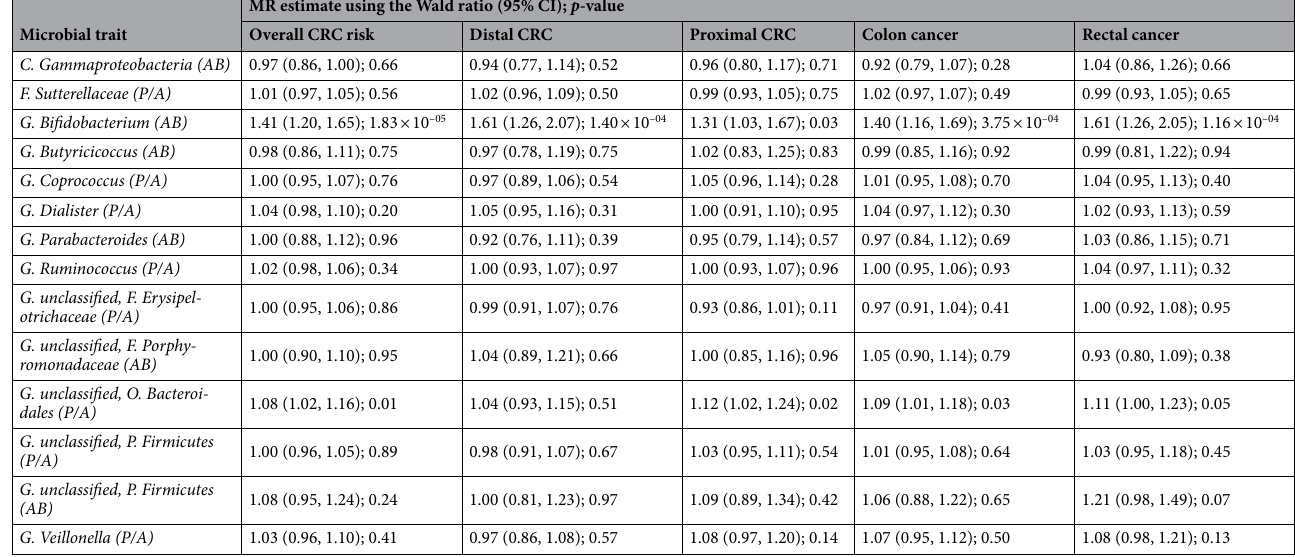
Table 1. Two-sample MR estimates of the effect of each microbial trait on overall and site-specific CRC risk. AB = abundance; CI = confidence interval; CRC = colorectal cancer; MR = Mendelian randomization; OR = odds ratio; P/A = presence versus absence. Letters in the microbial trait name represent the taxon classification level from which that microbial trait was observed, with “ C ”, “ F ”, “ G ”, “ O ” and “ P ” representing “class”, “family”, “genus”, “order” and “phylum”, respectively. All microbial traits that were not confidently classified at the genus level were organised into unclassified groups within higher classification levels (represented by “unclassified”). Effect estimates represent the OR for CRC risk for a standard deviation higher AB of each continuous microbial trait and the OR for CRC for an approximate doubling of the genetic liability to P/A of each binary microbial trait.